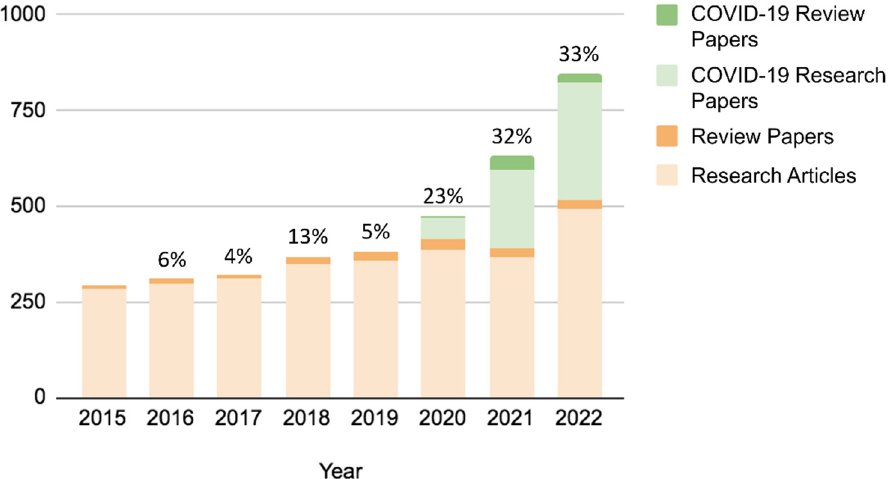
Figure 1. Trends in LAMP publications pre- and post-COVID-19 pandemic, analyzed through Scopus using keywords “LAMP” or “loop-mediated isothermal amplification.” A percentage increase from the immediate previous year is shown on top of each bar.